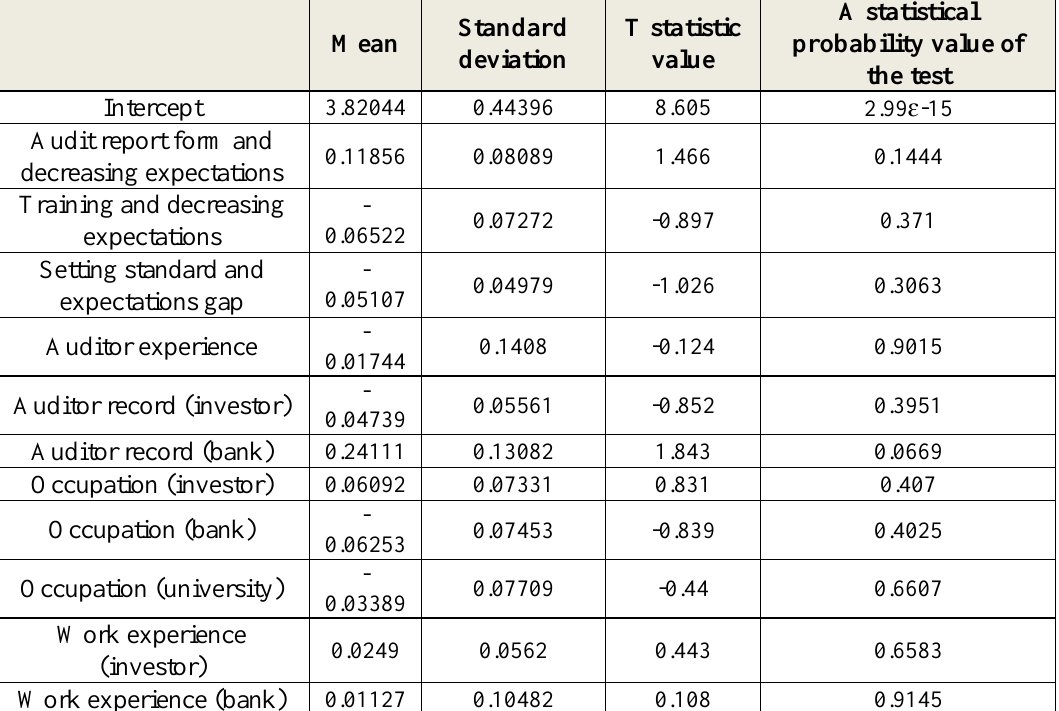
Table 8. Results of regression of the relationship between users of financial statements and